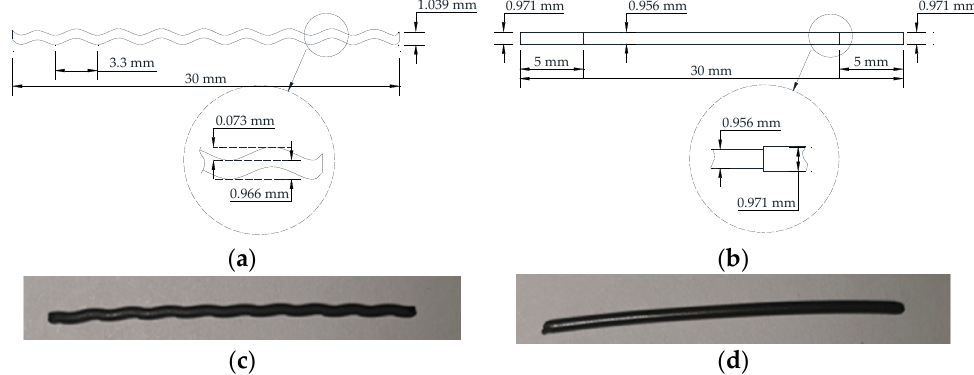
Figure 1. Shapes and dimensions of the fibers, ( a ) crimped fiber, ( b ) dog-bone-shaped fiber, ( c ) photo of a crimped fiber, and ( d ) photo of a dog-bone-shaped fiber.